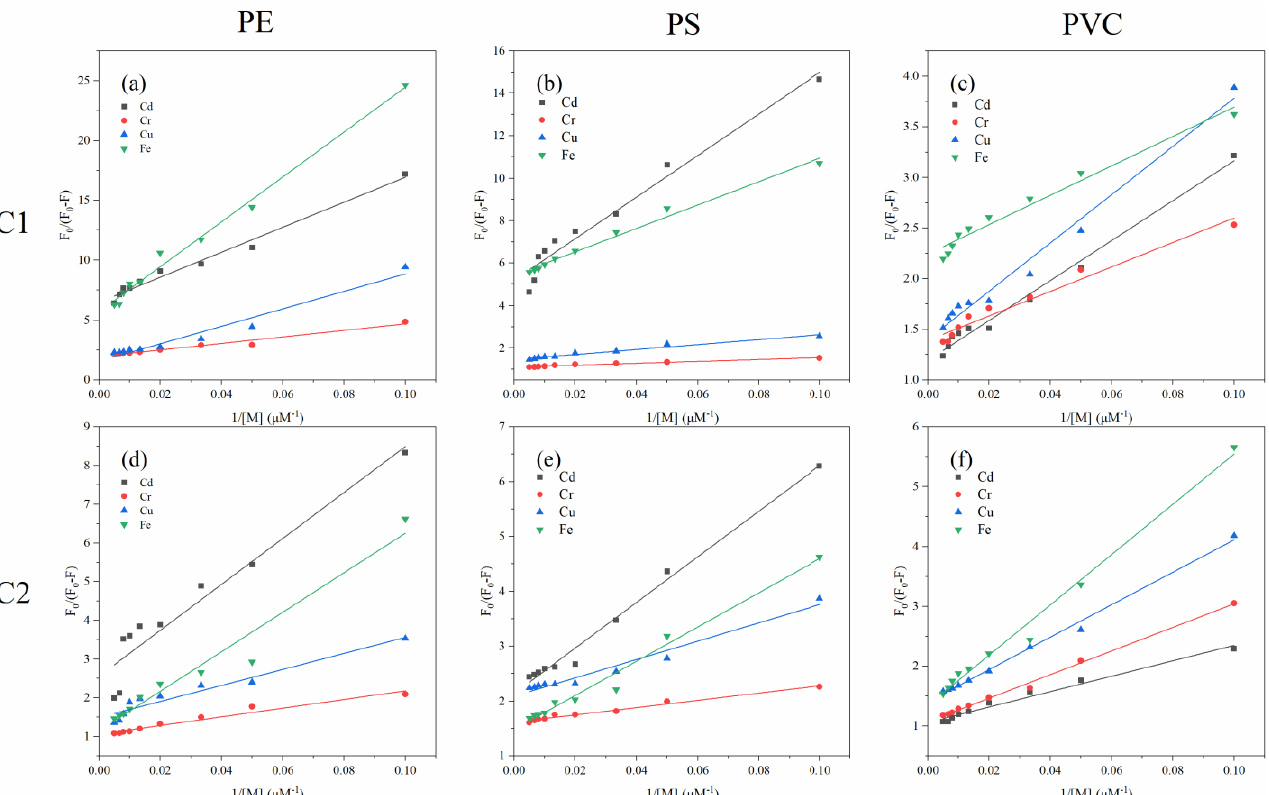
Figure 6. Modified Stern – Volmer plots of the fluorescence quenching of two individual fluorescent components of PE-DOM ( a , d ), PS-DOM ( b , e ), and PVC-DOM ( c , f ). Table 2. Metal-binding parameters of two different fluorescent components calculated by the mod- ified Stern – Volmer equation using the MP-DOM samples.